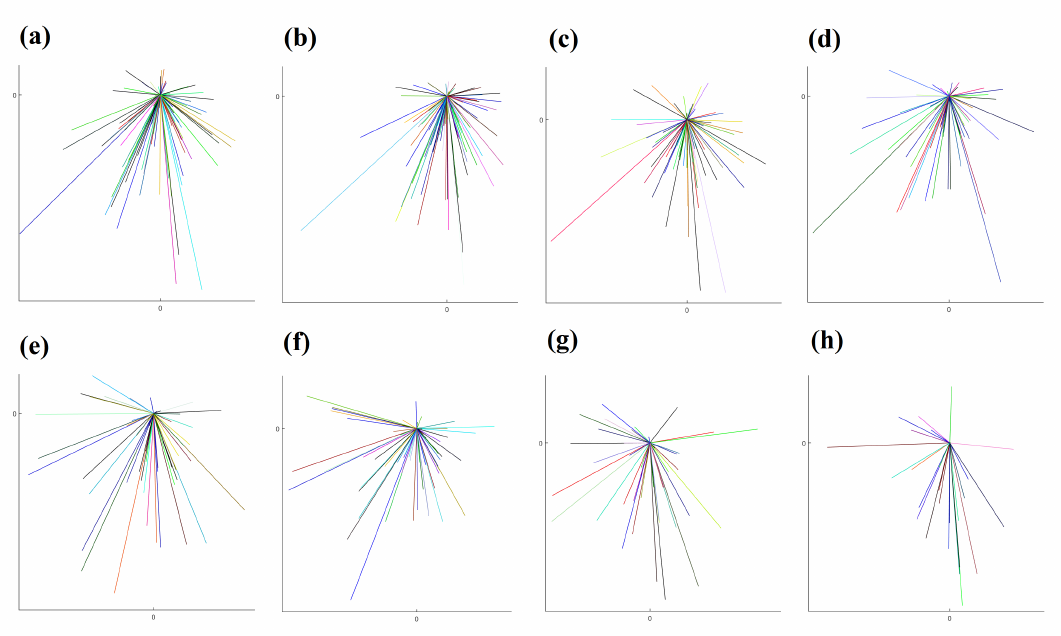
Figure 5. The plots demonstrate graphically directed cell migration patterns from Dataset 2